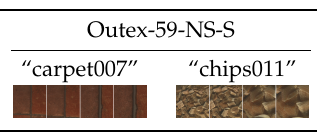
Figure 8. Group #8: Non-stationary textures with variations in scale (Section 3.2.8).